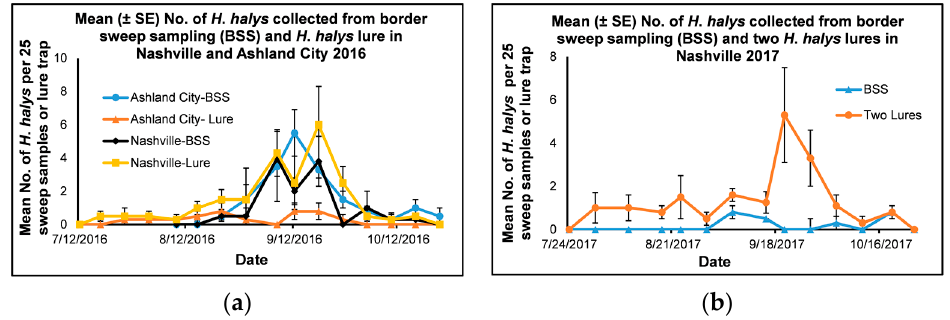
Figure 3. Mean (±SE) number of adult and immature Halyomorpha halys per 25 sweep samples/block collected from ( a ) border sweep sampling (BSS) or H . halys lure (Dead-Inn Combo Xtra lure) in soybeans from July to October 2016 conducted in Ashland City (Cheatham County) and Nashville (Davidson County), Tennessee ( b ) border sweep sampling (BSS) or both H . halys lures (Dead-Inn Combo Xtra and HALHAL 25) in soybeans from July to October 2017 conducted in Nashville (Davidson County), Tennessee.